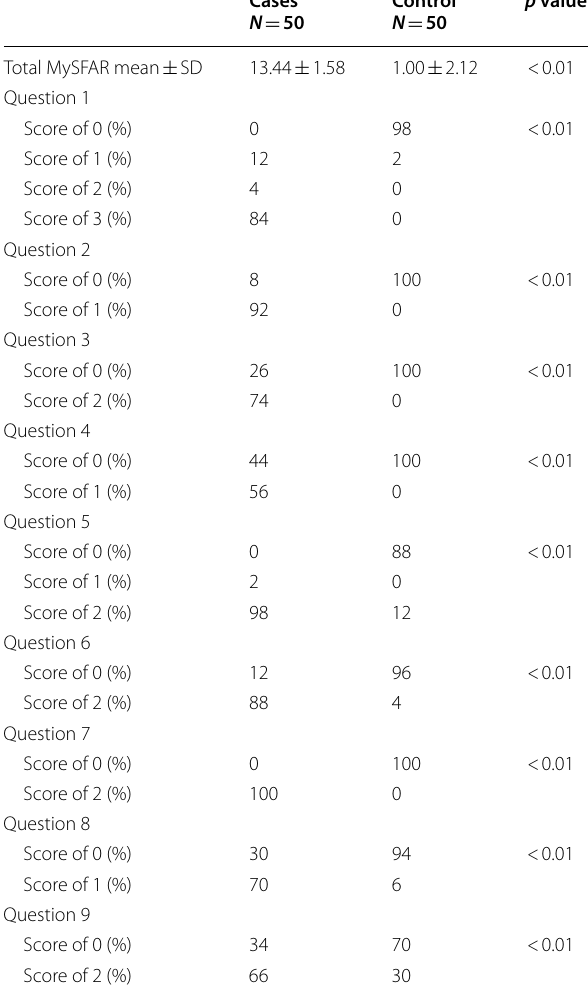
Table 2 Comparison of the MySFAR scores between allergic rhinitis patients and healthy